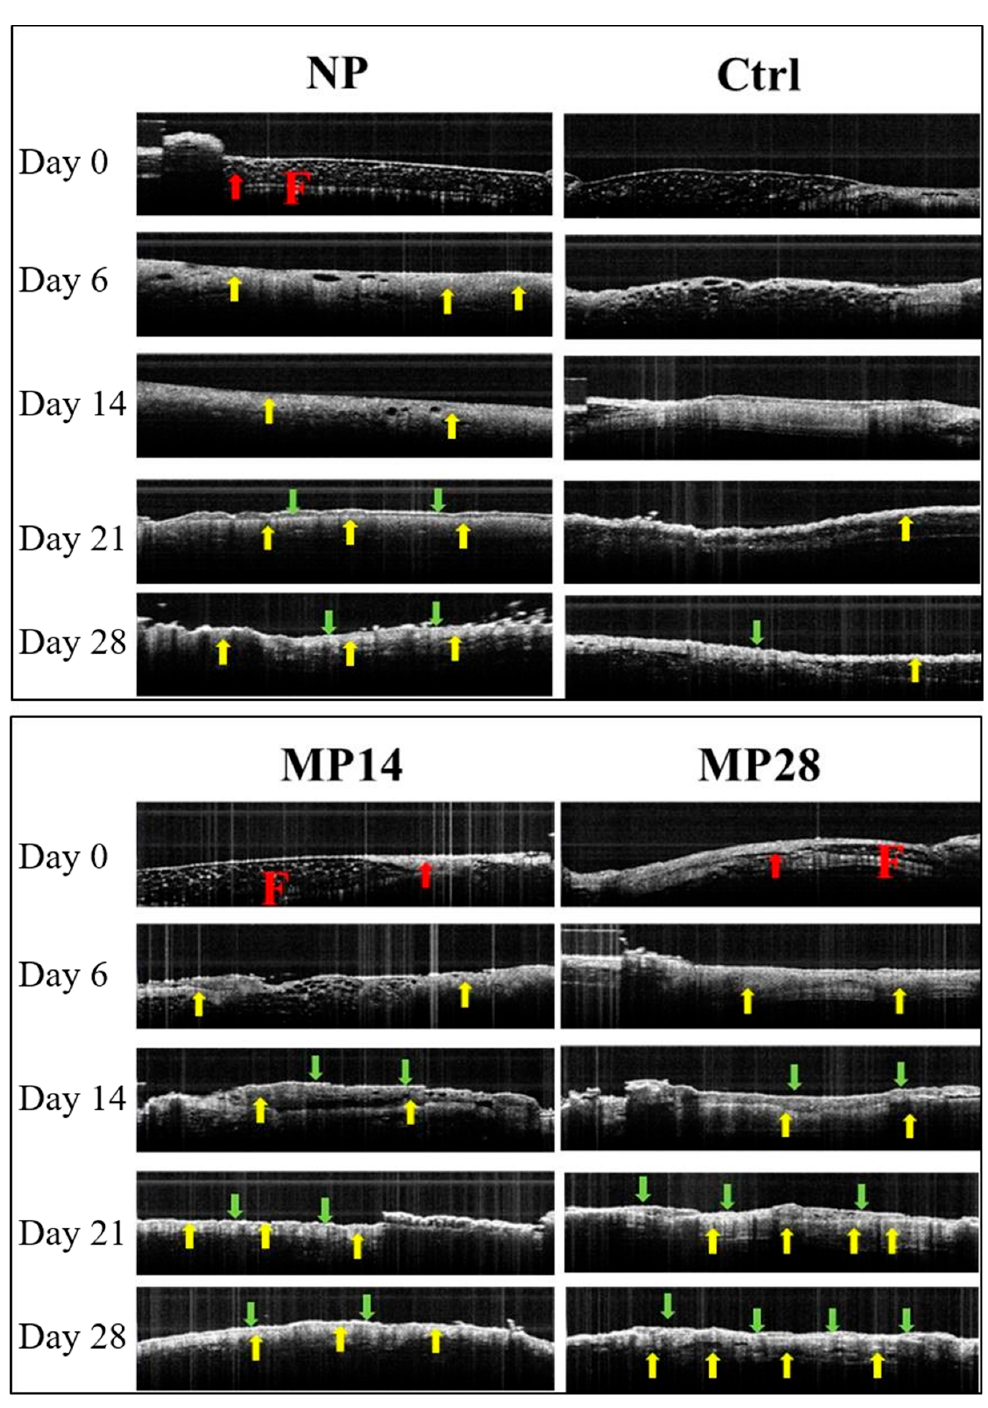
Figure 2. MP treatment promoted wound bed re-epithelialization on days 0, 6, 14, 21, and 28 (Study 1): Representative OCT images were acquired for the NP, control, MP 14, and MP 28 groups. “F” marked in red in the NP and MP14 groups indicates the tissue fluid; the red, yellow, and green arrows represent the muscle, dermis, and epidermis layers, respec- tively.